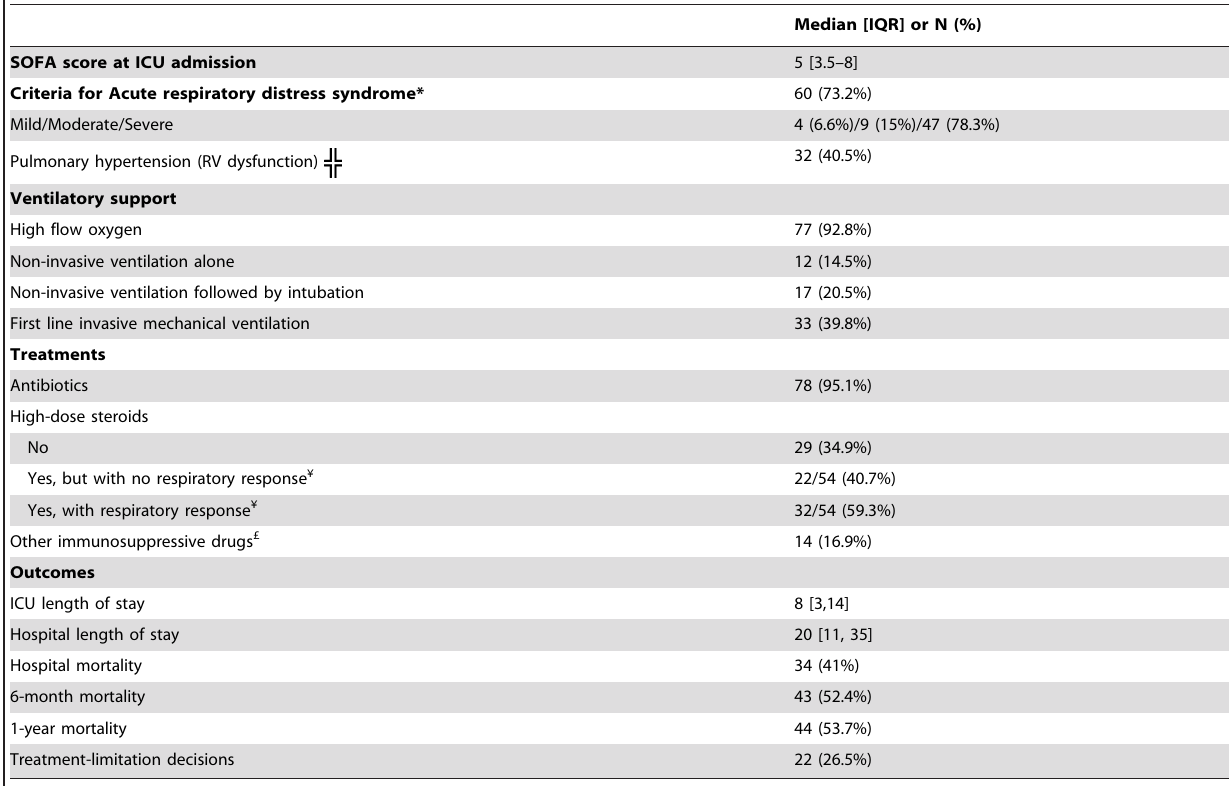
Table 2. Severity, ICU management and